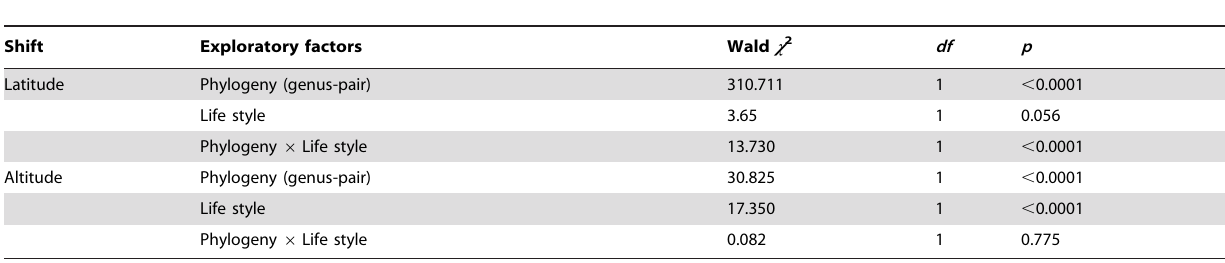
Table 2. Results from a generalized linear model (GLM) testing the effects of two explorative factors (phylogeny and lifestyle) on how spiders respond to climate conditions (based on the IPCC scenario A1B for temperature and precipitation) by shifting latitude or